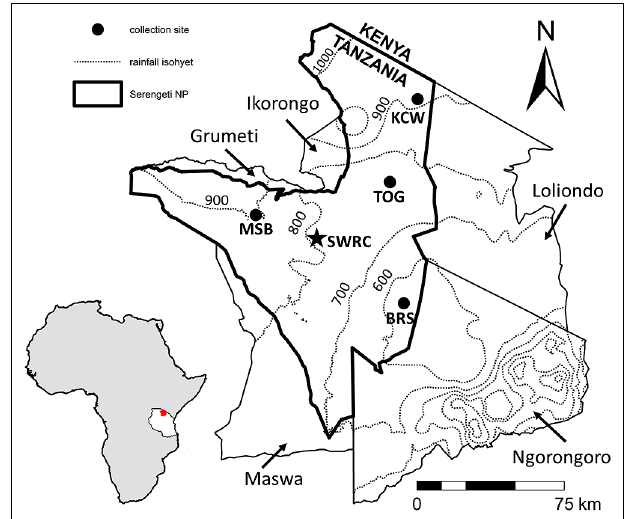
FIGURE 1 | Map showing the locations of the four collection sites of Digitaria and Themeda in Serengeti National Park; surrounding protected areas are directly labeled. Inset of Africa shows the location of this region in northernTanzania in red.The common garden was constructed at the central SerengetiWildlife Research Centre (SWRC). Mean annual precipitation is approximately 498 mm/yr at BRS, 676 mm/yr atTOG, 766 mm/yr at KCW, and 891 mm/yr at MSB (values from Anderson etal.,